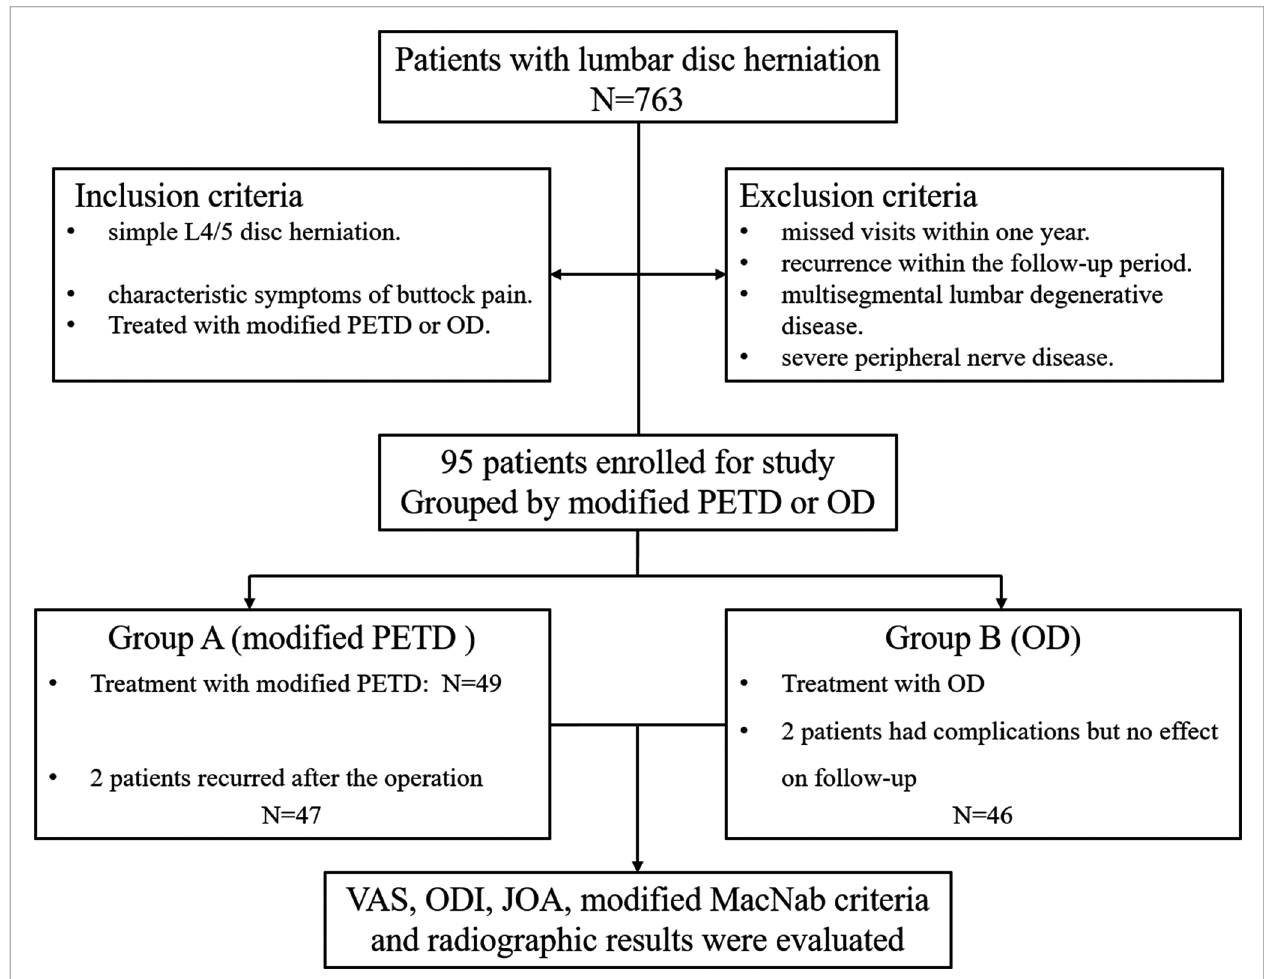
FIGURE 1 | Flow chart of patient inclusion and strati fi cation. Modi fi ed PETD, modi fi ed percutaneous endoscopic transforaminal discectomy; OD, open lumbar